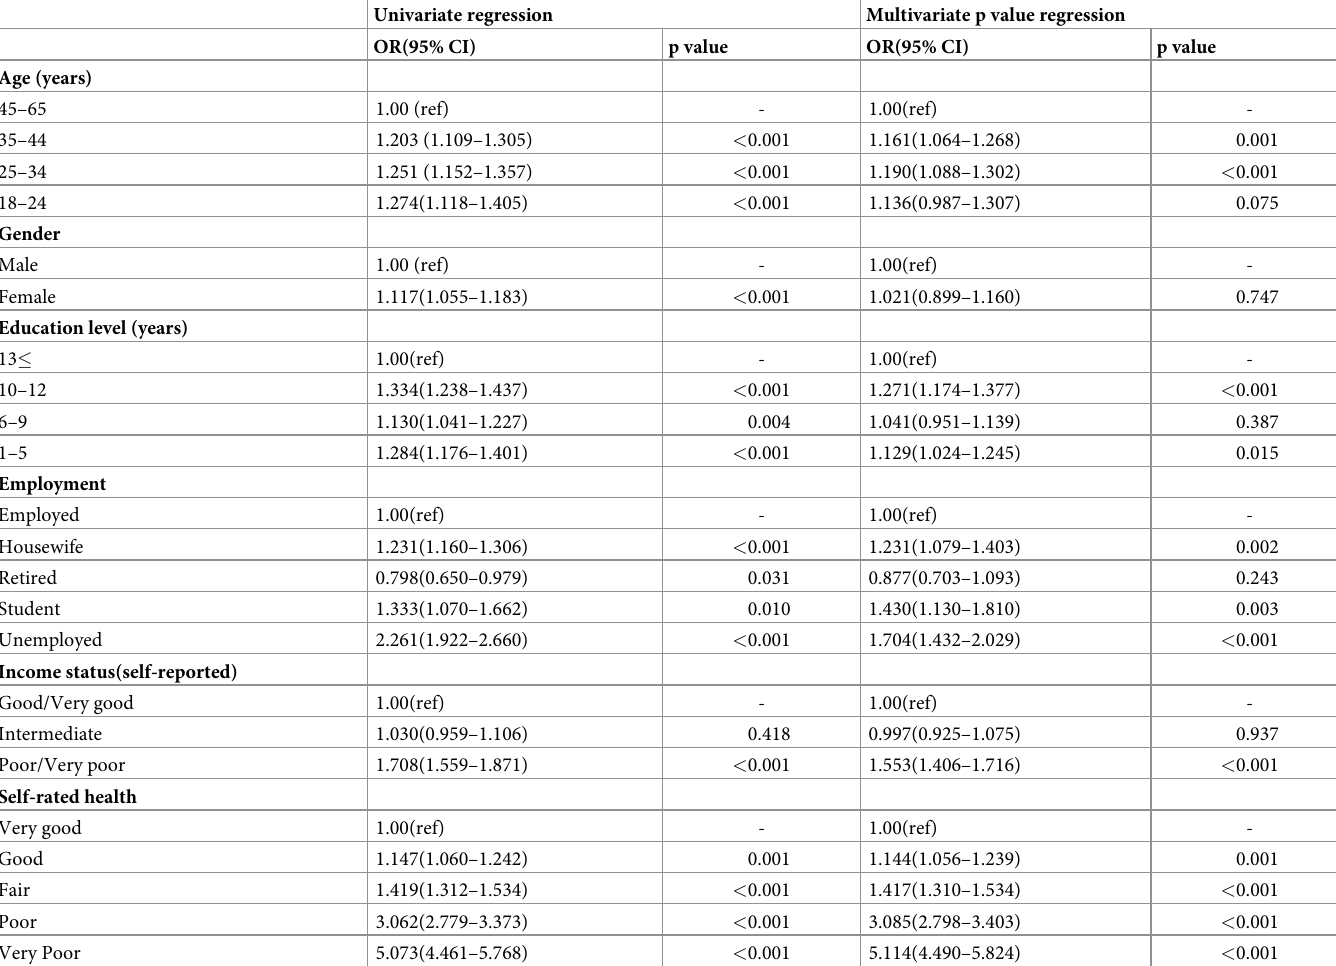
Table 4. Relationship between Oxford happiness scores, health status and demographic